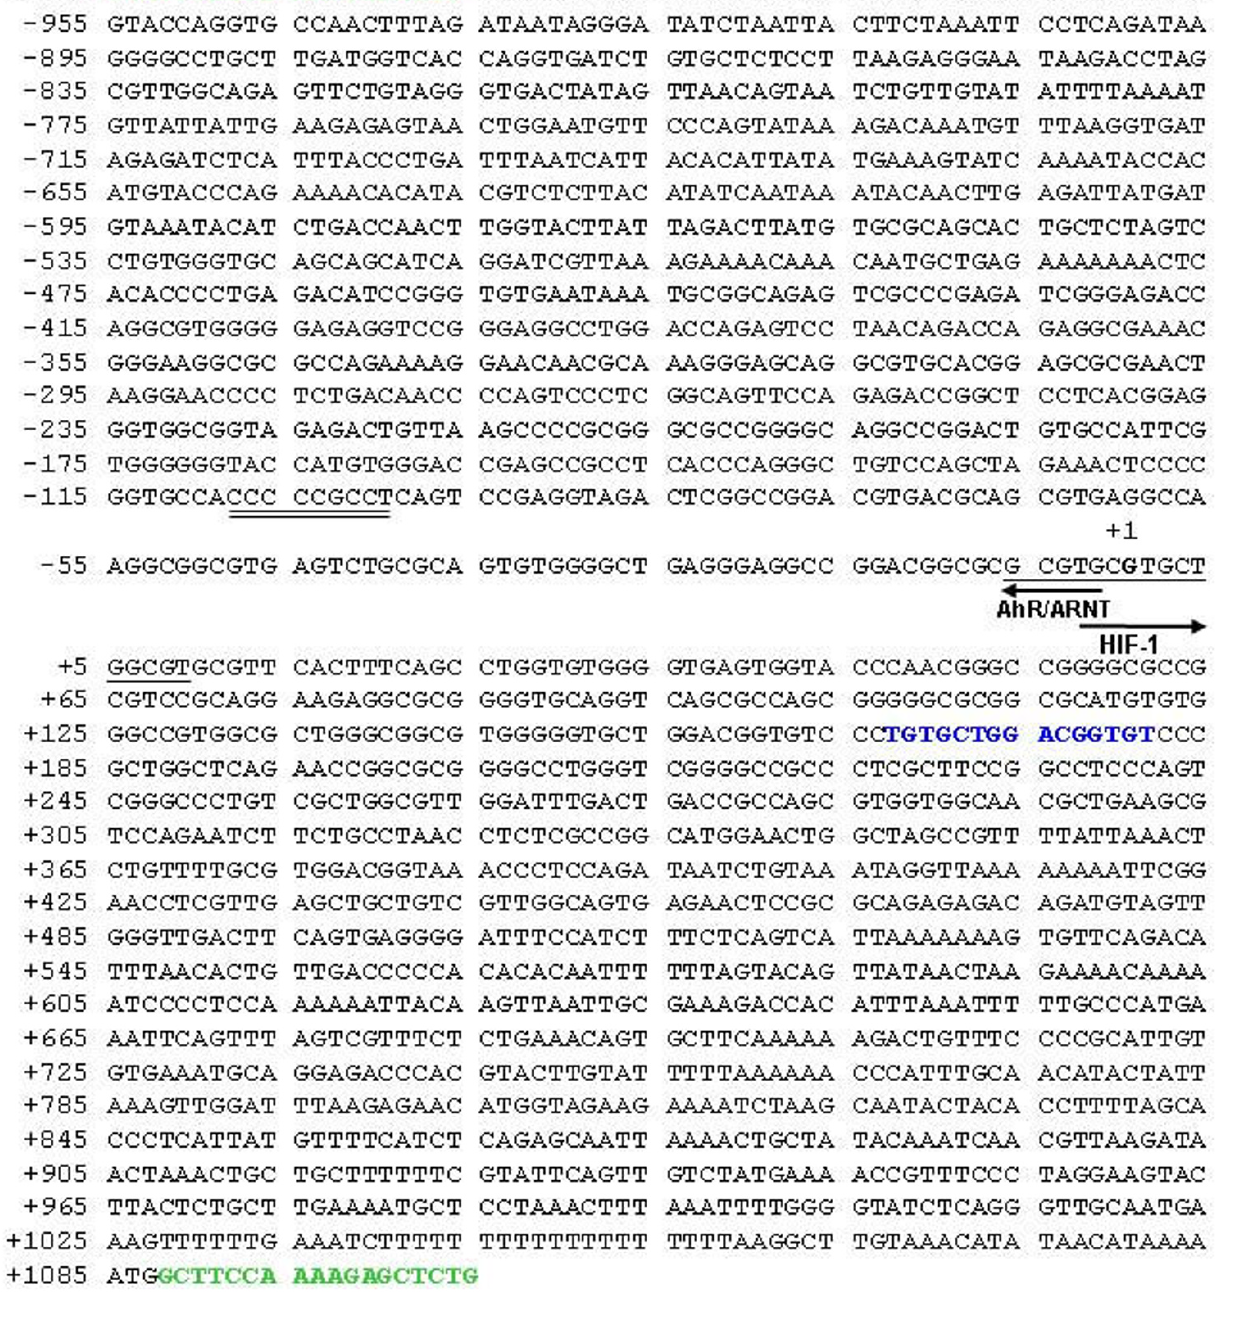
Figure 1 Nucleotide sequence of the promoter region of the human DJ-1 gene (GenBank Accession number AB045294 ) showing the positions of significant sites . The +1 indicates the transcription start site. The position of the 16 bp deletion sequence is indicated by a single underline and the Sp1 site by a double underline. The position of the 18 bp insertion/deletion polymorphism (g.168_185del) is indicated in blue font and the positions of the primers used to generate the luciferase con- structs are shown in bold green font. The positions of putative cis -motifs (AhR/ARNT and HIF-1) present in the 16 bp deletion sequence are indicated by